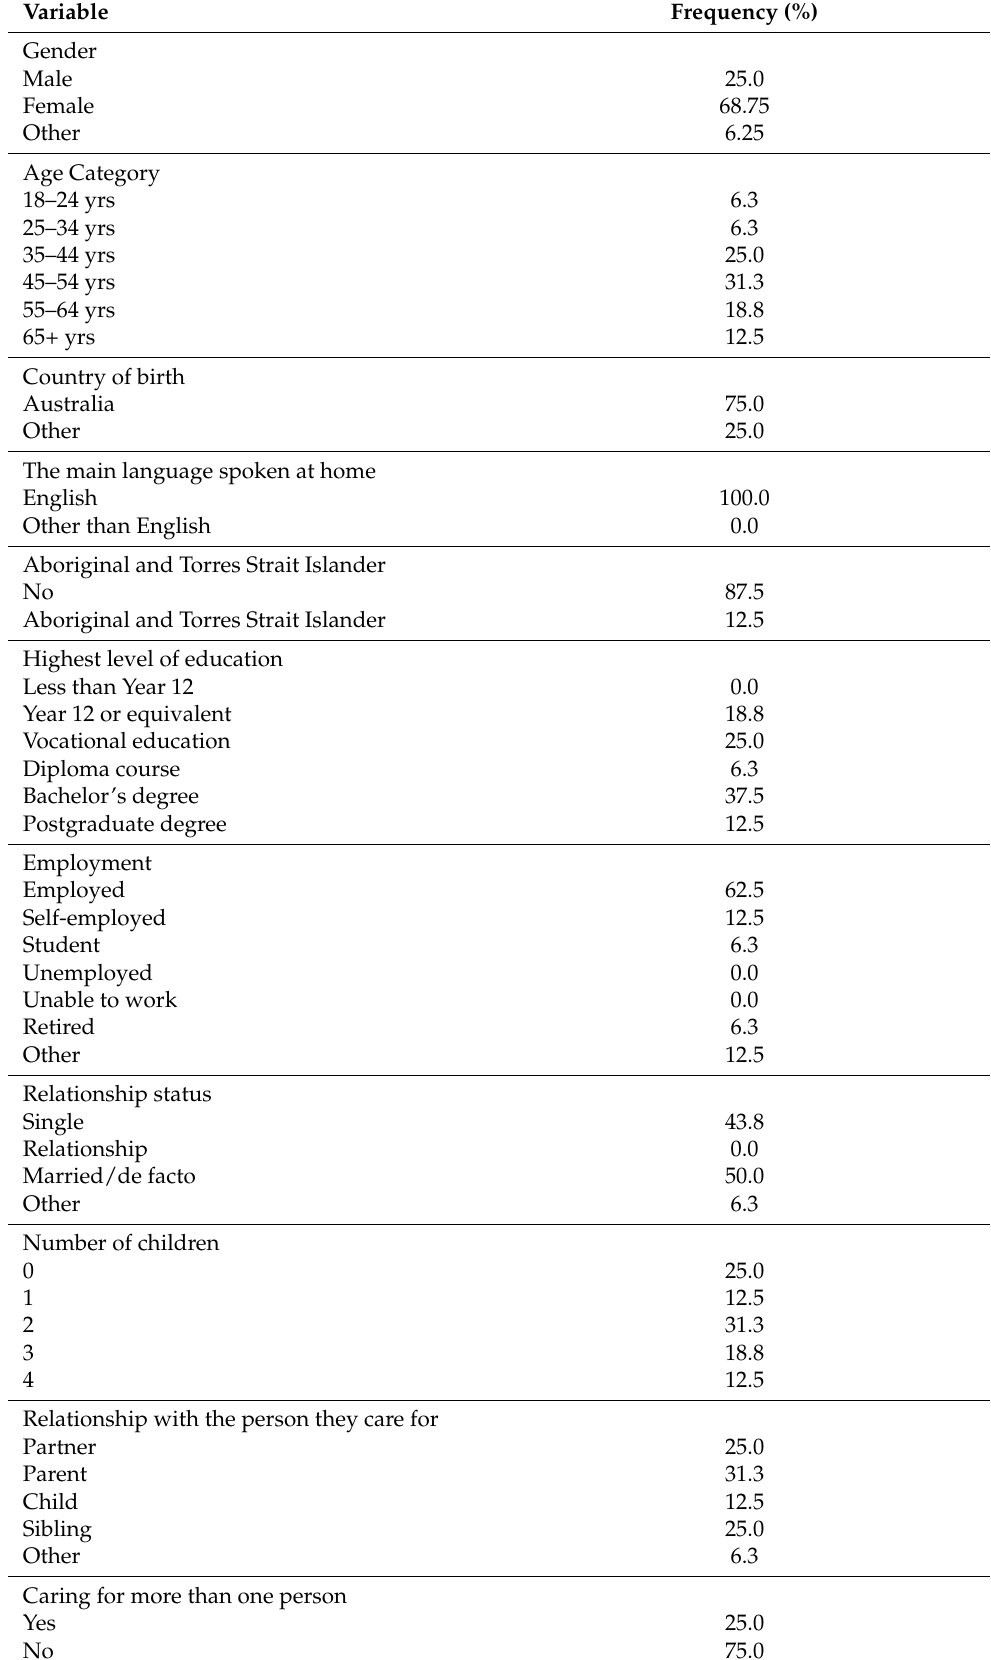
Table 1. Sociodemographic profile of families (program